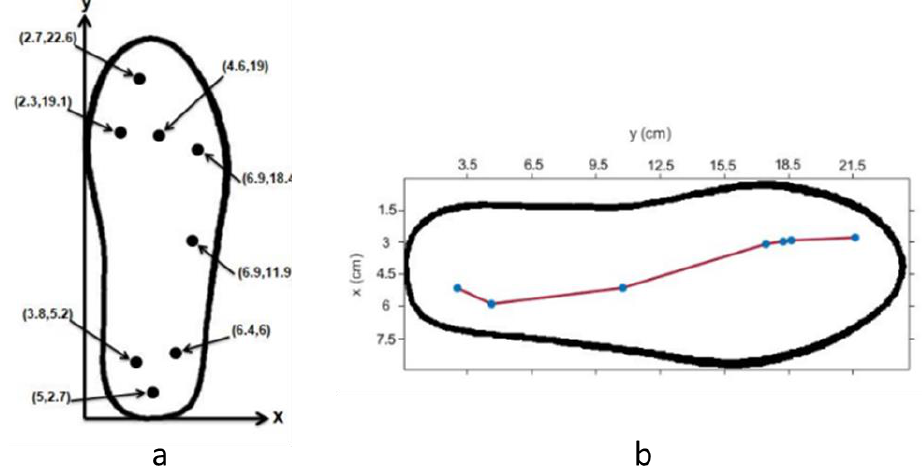
Figure 12. COP calculations ( a ) The positions of eight sensors in the Cartesian coordinate system ( b ) The instantaneous displacement of the center of plantar pressure during the stance phase.